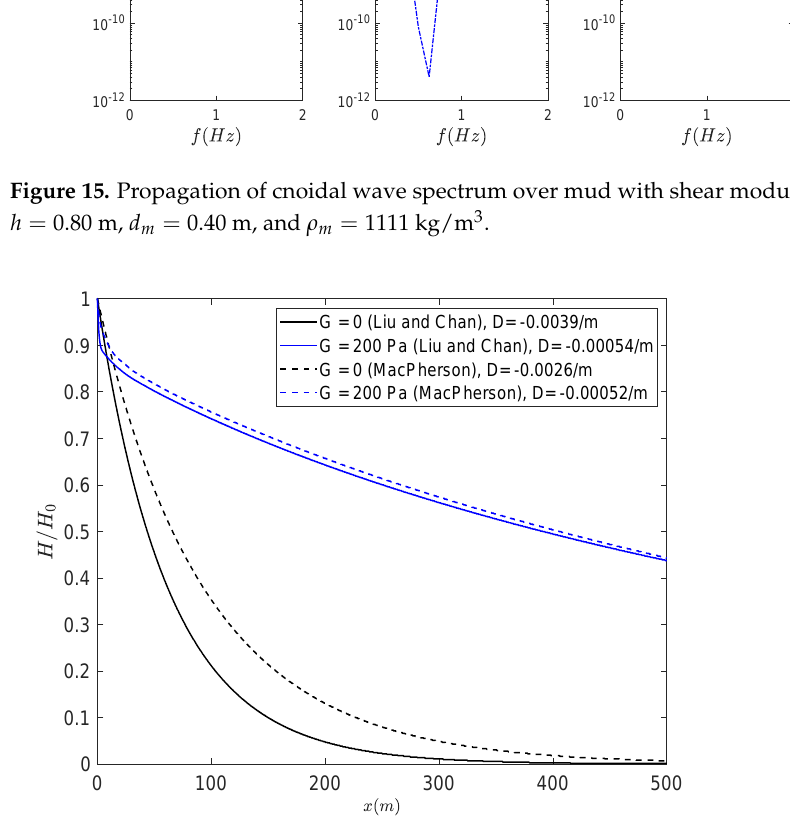
Figure 16. Spatial variation of cnoidal wave height, H , over viscous ( G = 0) and viscoelastic mud with shear modulus of G = 200 Pa, as normalized by incident wave height H 0 , solid-line: LC, dashed-line: Macpherson [17]. The mud patch is located at x = 300–800 m, ζ = 100, h = 0.80 m, d m = 0.40 m, and ρ m = 1111 kg/m 3